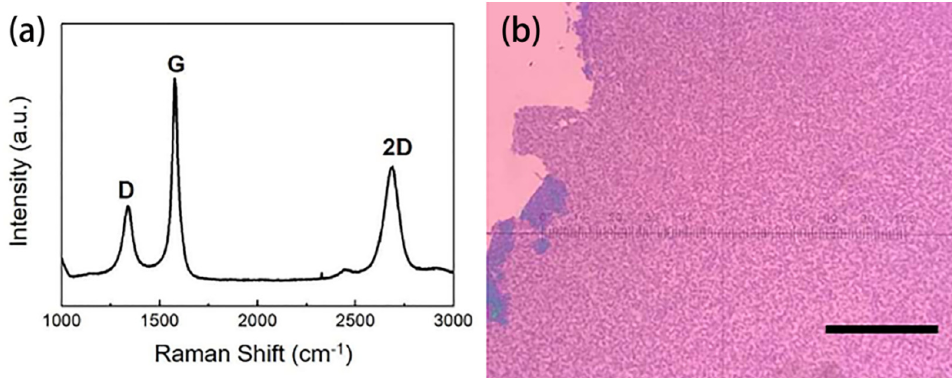
Figure 14. ( a ) Raman spectra of graphene grown in situ catalyzed by cobalt. ( b ) The optical image of graphene grown in situ catalyzed by cobalt, with a scale of 30 μ m.